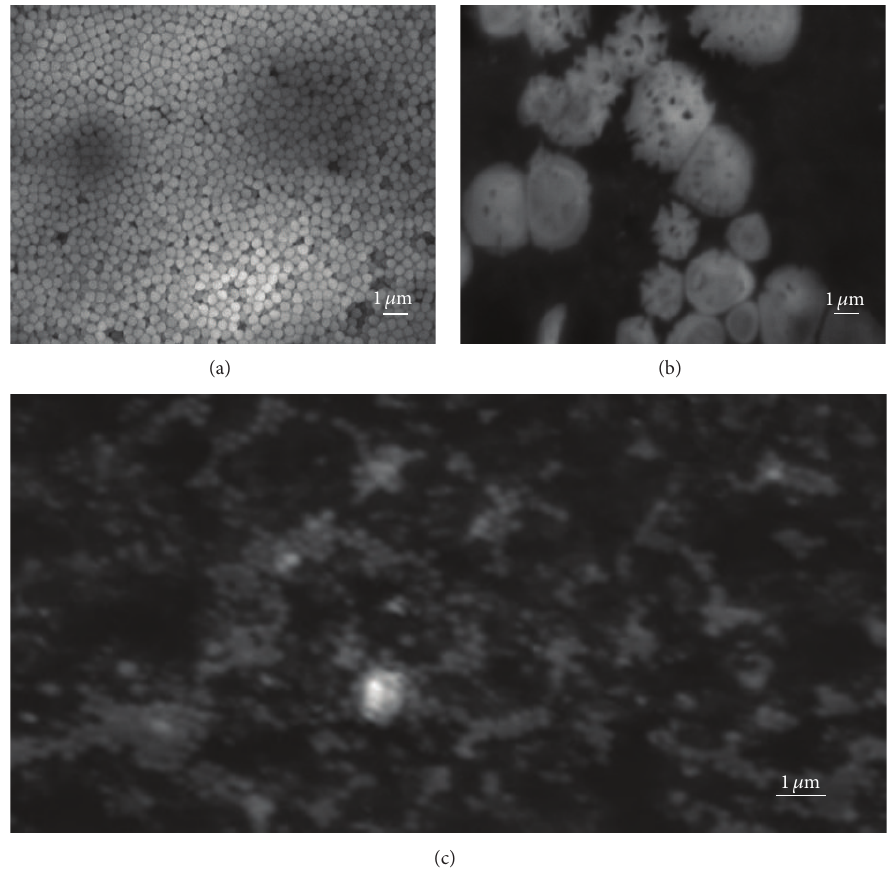
Figure 4: SEM images of SiO 2 (a), H 4 SiW 6 Mo 6 O 40 (b), and H 4 SiW 6 Mo 6 O 40 /SiO 2